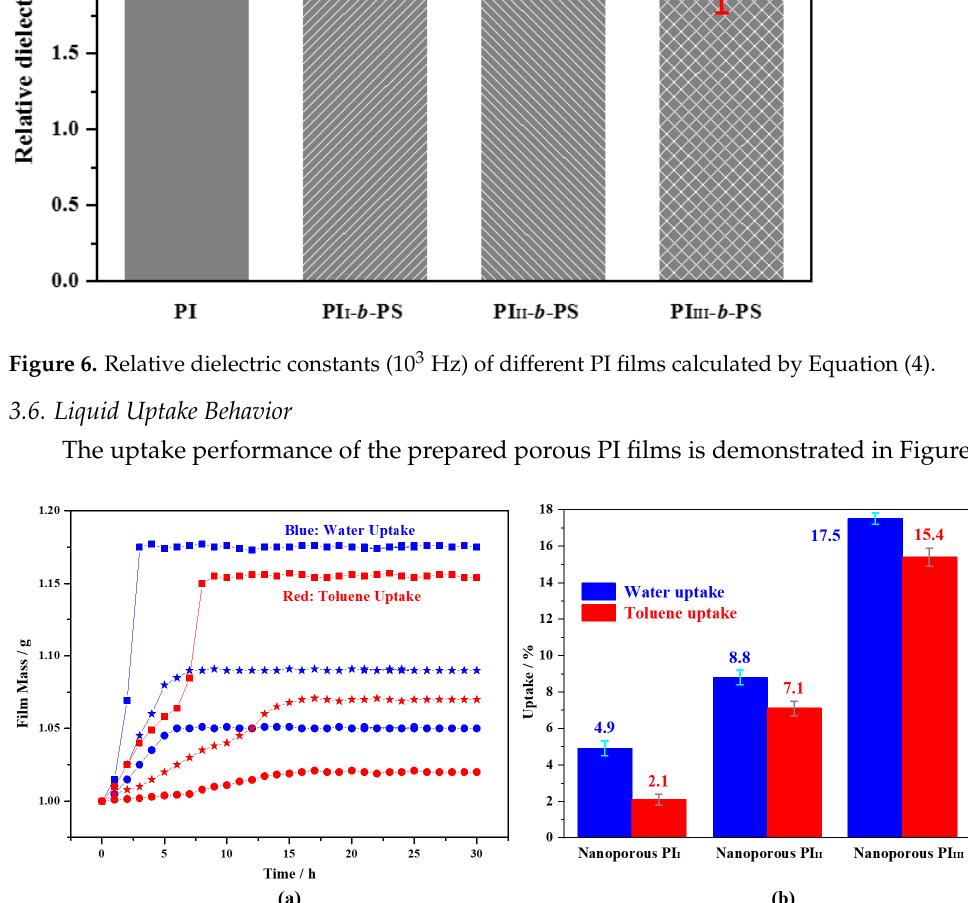
Figure 6. Relative dielectric constants (10 3 Hz) of different PI films calculated by Equation (4).